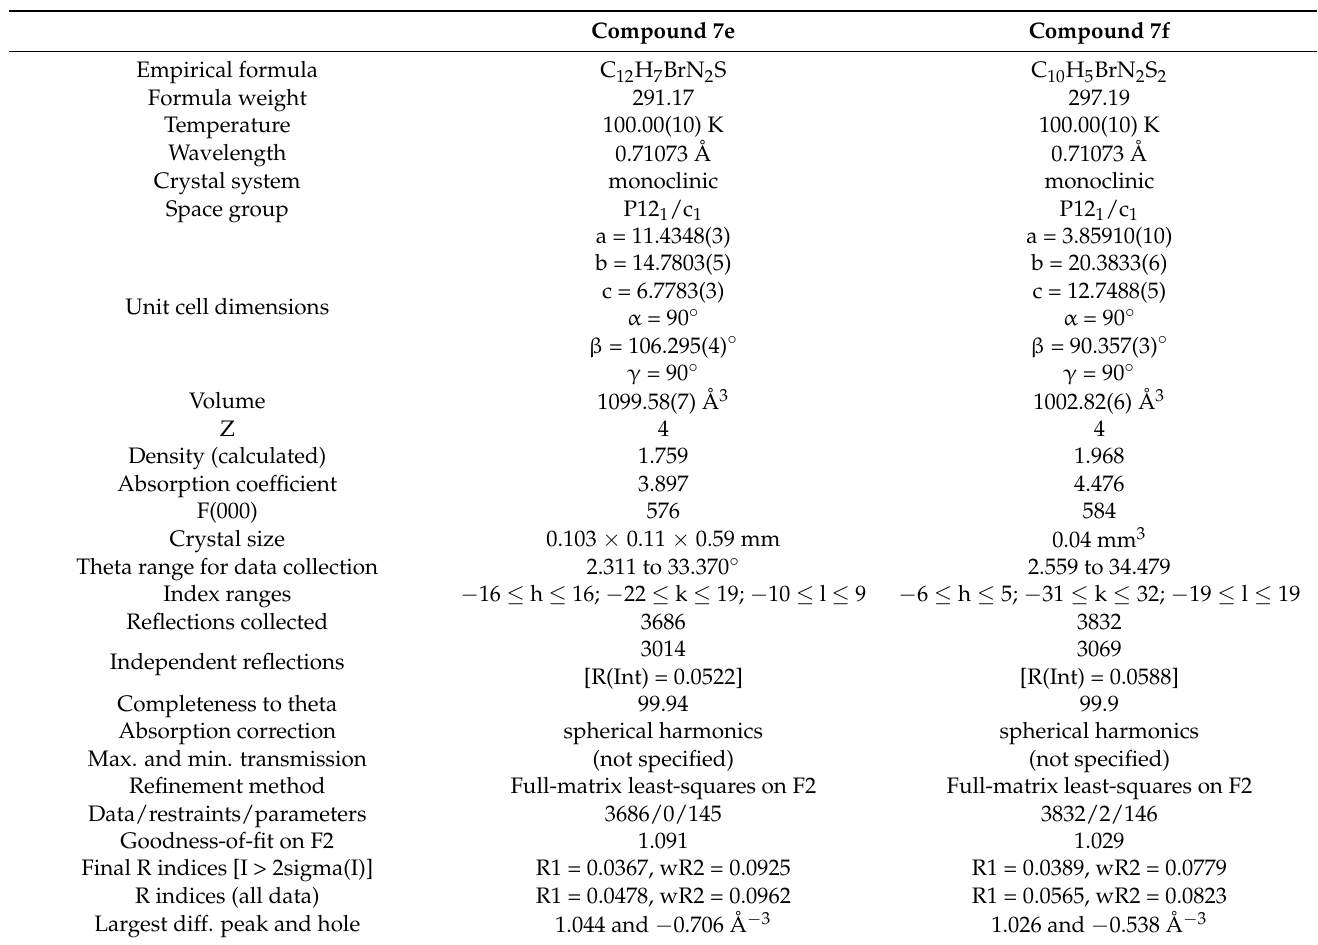
Table 9. Crystal data and structure refinement for compound 7e and 7f